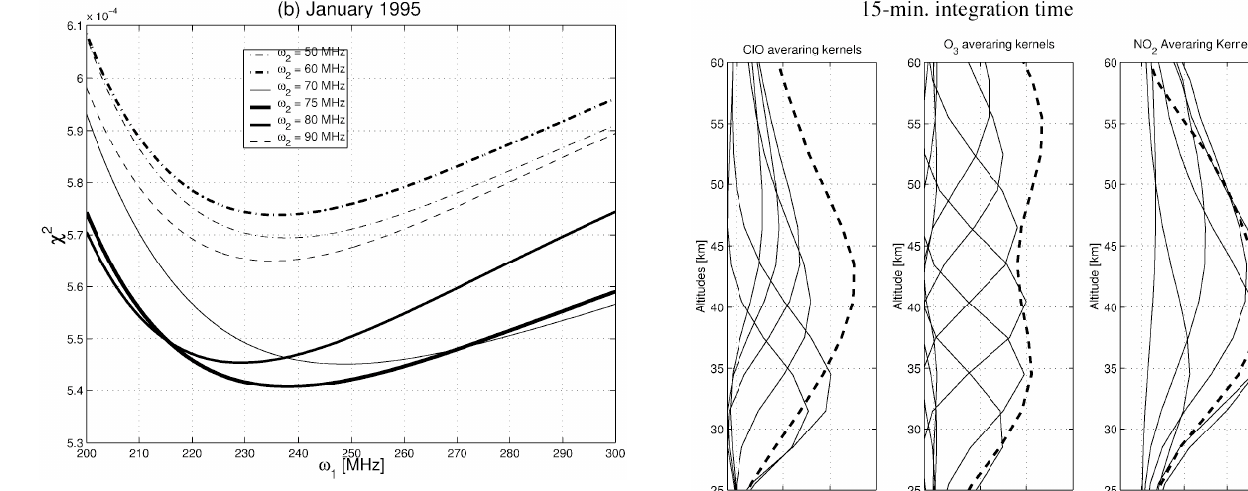
Fig. 6. Same as Fig. 5 but for a baseline measured in January 1995.